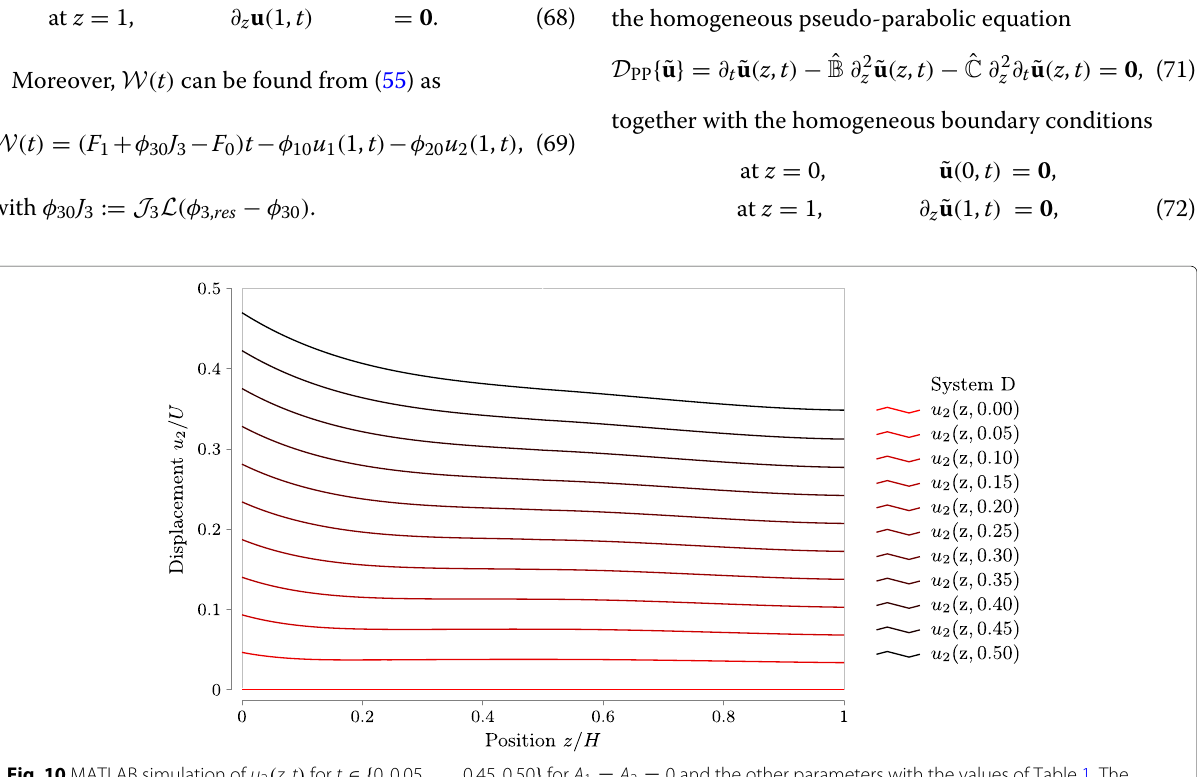
Fig. 10 MATLAB simulation of u 2 ( z , t ) for t ∈ { 0,0.05, ... ,0.45,0.50 } for A 1 = A 2 = 0 and the other parameters with the values of Table 1. The oscillations in the graphs are due to an unphysical alternating-in-time solution of v 3 ( z , t ) in the MATLAB